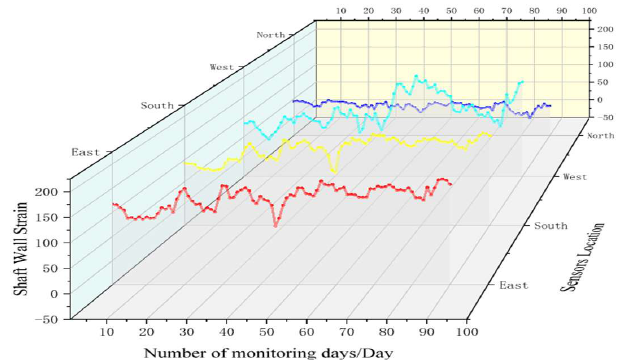
Figure 13. The FBG sensing strain diagram (640 m).